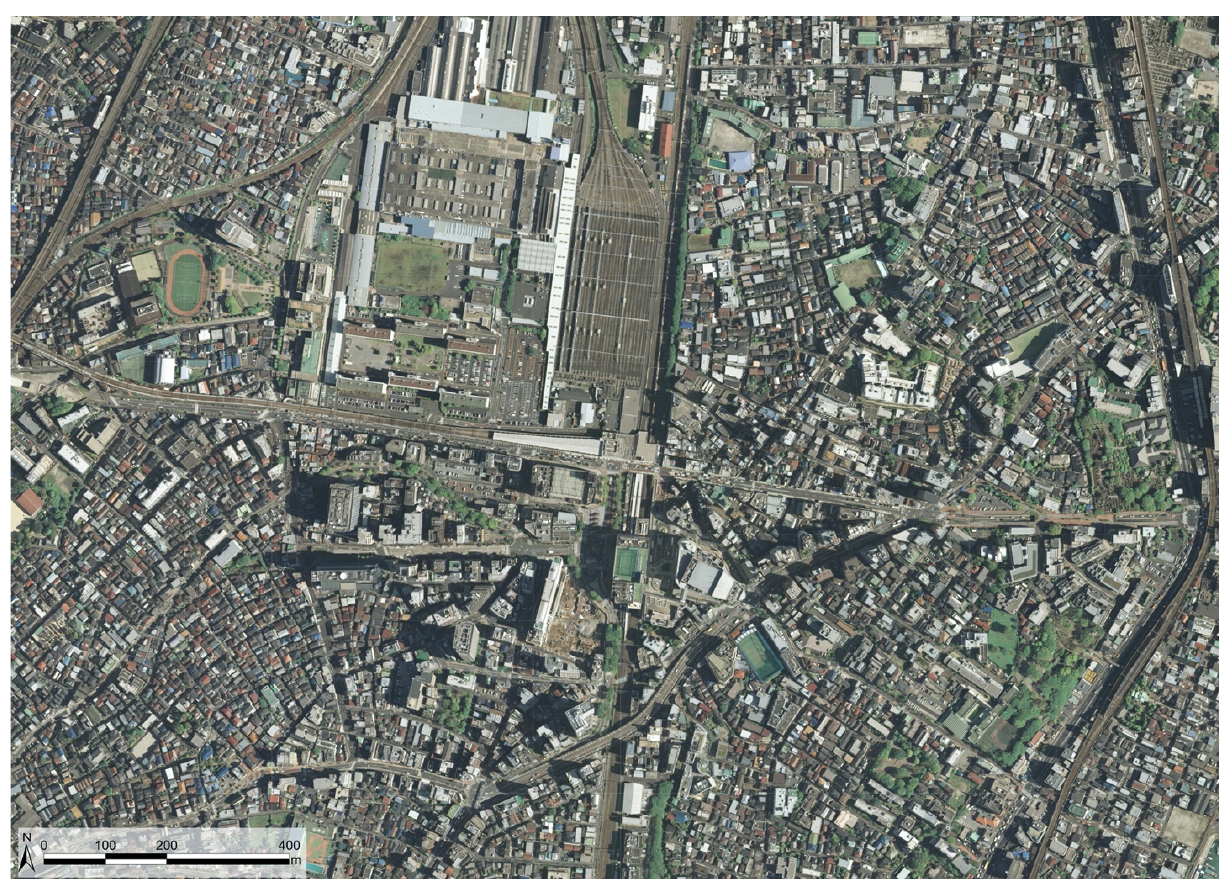
Figure 2. The area around Oimachi station, Japan. Source: Google Earth. residential, 7.2% commercial, 31% office and